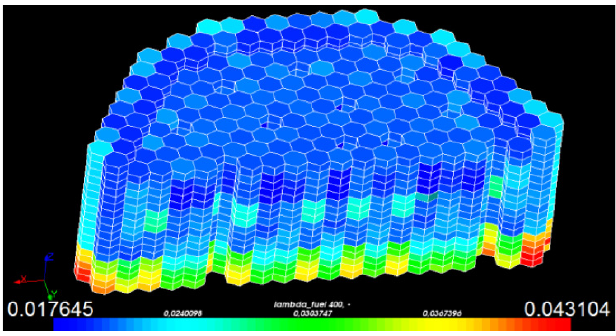
Fig. 7. Typical 3D map of l